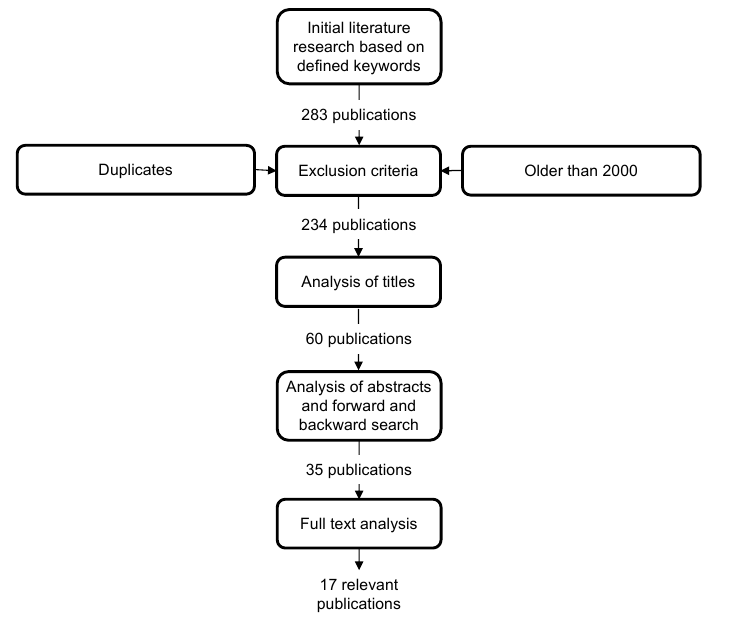
Figure 3. Methodology of the search